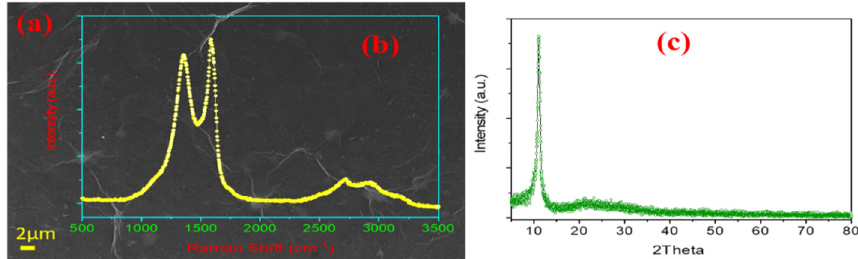
Figure 7. ( a ) FESEM micrograph, ( b ) Raman spectrum, and ( c ) XRD pattern of the GO film deposited on Si/SiO 2 substrate before the growth of the WS 2 layer.